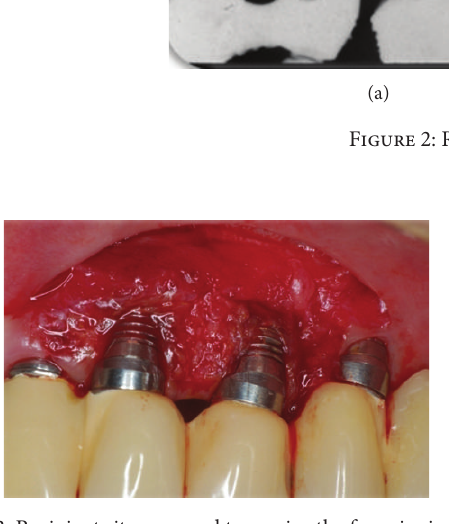
Figure 3: Recipient site prepared to receive the free gingival graft. Figure 4: Graft sutured into the recipient site only in keratinized mucosa and